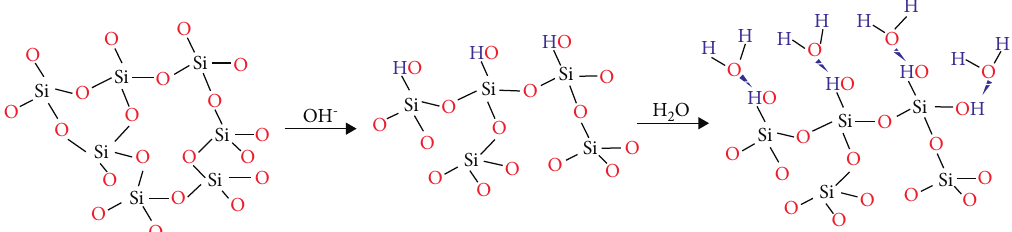
Figure 7: Schematic of the processes of amorphous SiO